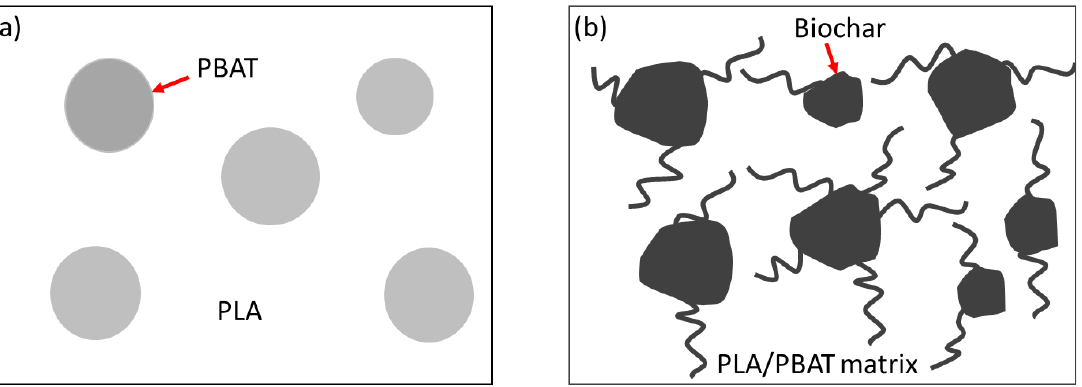
Figure 9. Schematic diagram of ( a ) phase-separated PLA/PBAT blend and ( b ) biochar polymer matrix interaction in PLA/PBAT/biochar composites.